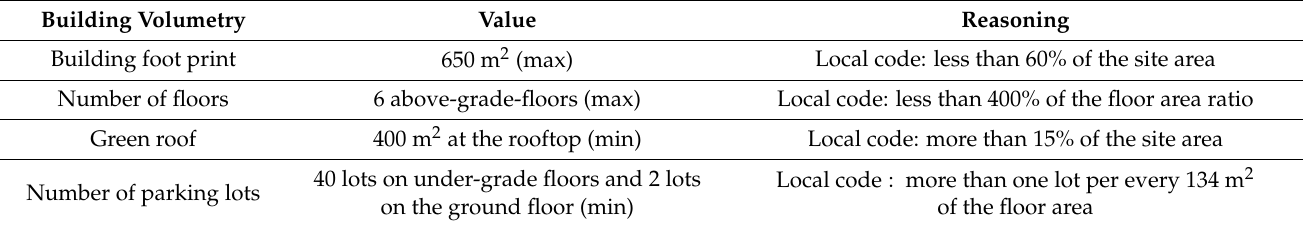
Table 4. Volume and mass of the test building.